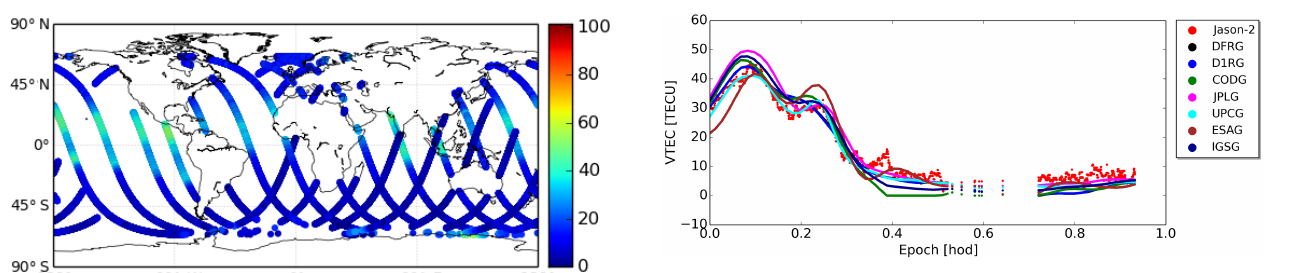
Figure 9. VTEC values from the six analysis centers and Jason-2 between 00:00 and 01:00UTC on DOY 229, 2016 in